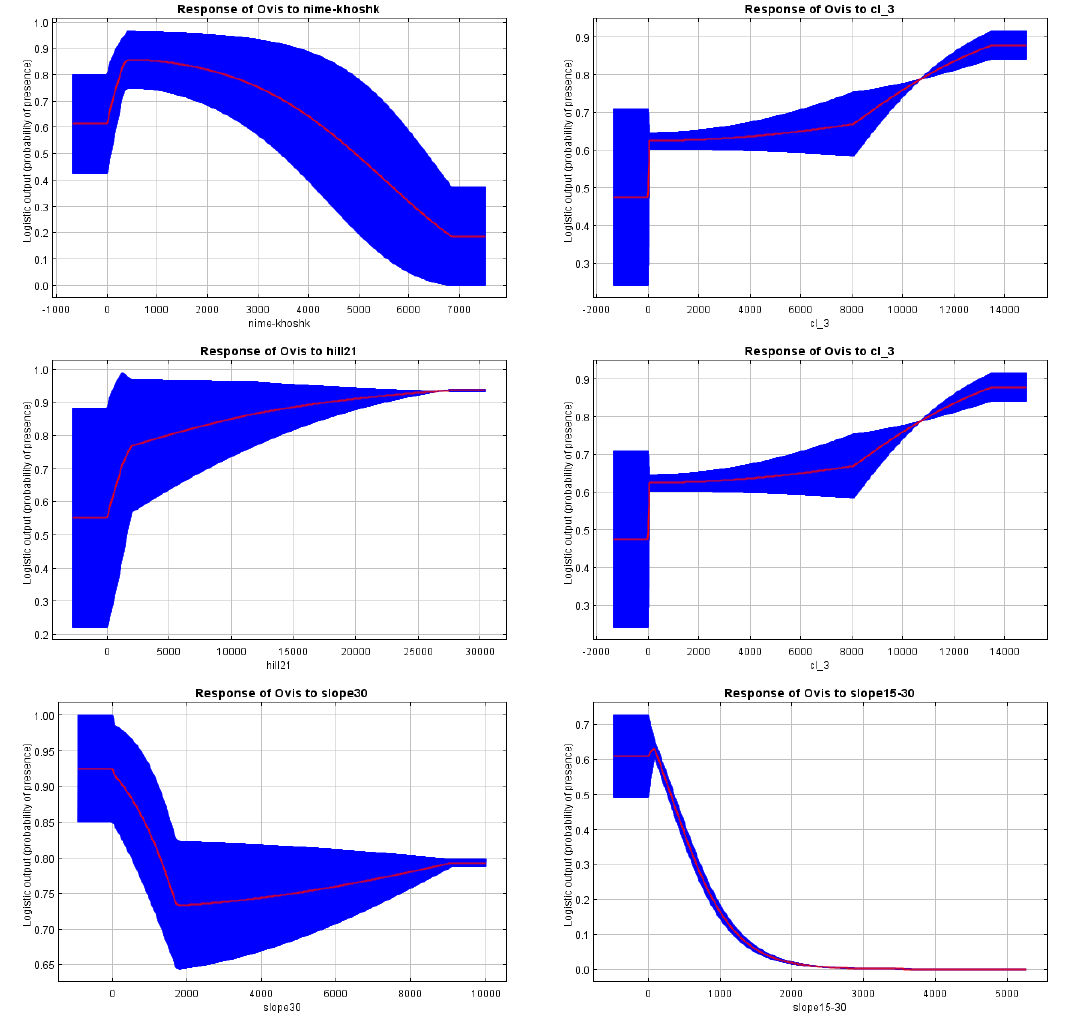
Figure 6. The response curves of Urial to environmental